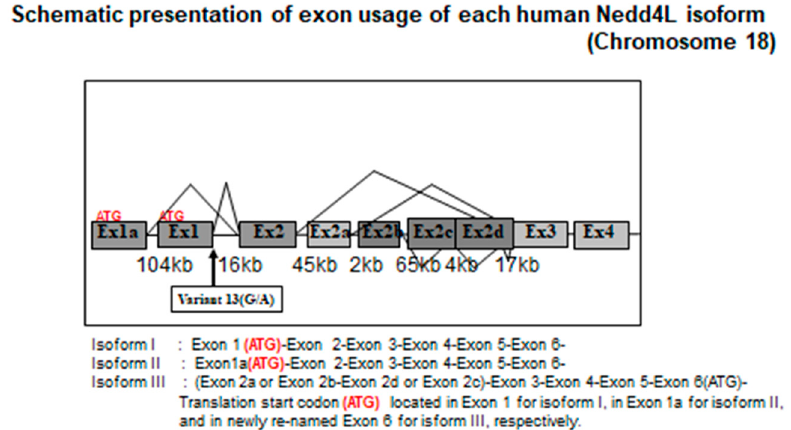
Figure 2. Schematic presentation of exon usage of each human Nedd4L isoform is shown. Exon in dark square shows the newly discovered exons through re-sequencing. Variant 13 (G → A) located at the end of the newly discovered exon 1. Translation start codon (ATG) located in Exon 1 for isoform I, in Exon 1a for isoform II, and newly re-named Exon 6 for isoform III, respectively. (modified from [45])